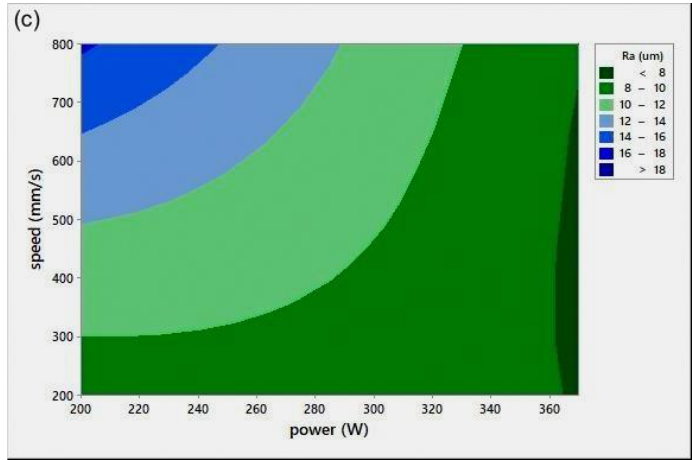
Figure 8. Scan speed ( v )-laser power ( P )-surface roughness (Ra) maps for different hatch spacing ( h ) values: ( a ) h = 0.05 mm, ( b ) h = 0.08 mm, and ( c ) h = 0.1 mm.